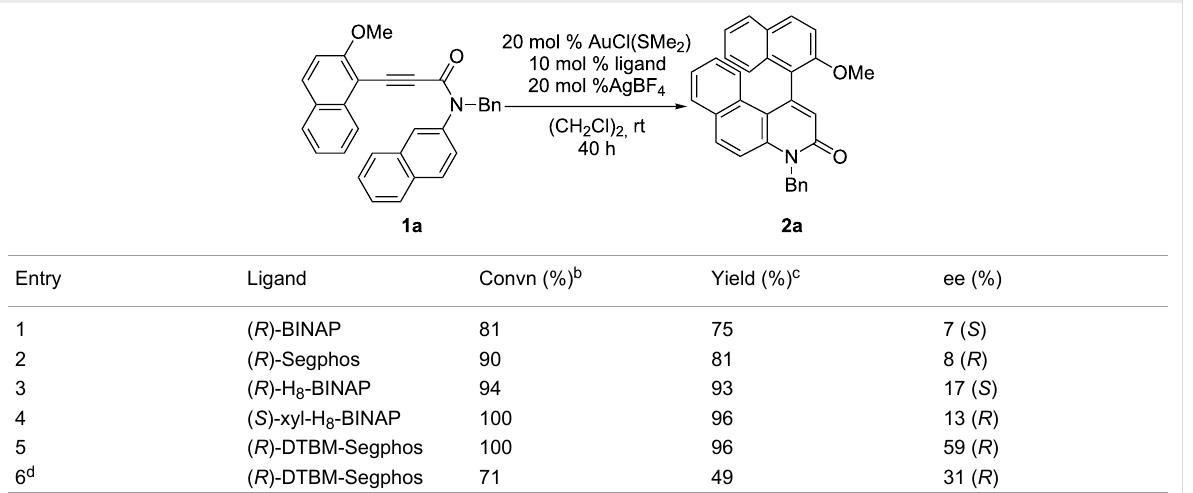
Table 1: Screening of axially chiral biaryl bisphosphine ligands for the cationic gold(I)-complex catalyzed atropselective intramolecular hydroarylation of 1a .